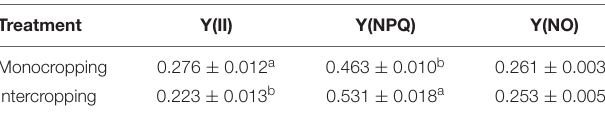
TABLE 4 | Effect of high light on the mode of the yields for dissipative processes for the energy absorbed by PSII of soybean at midday (12:30 pm). Treatment